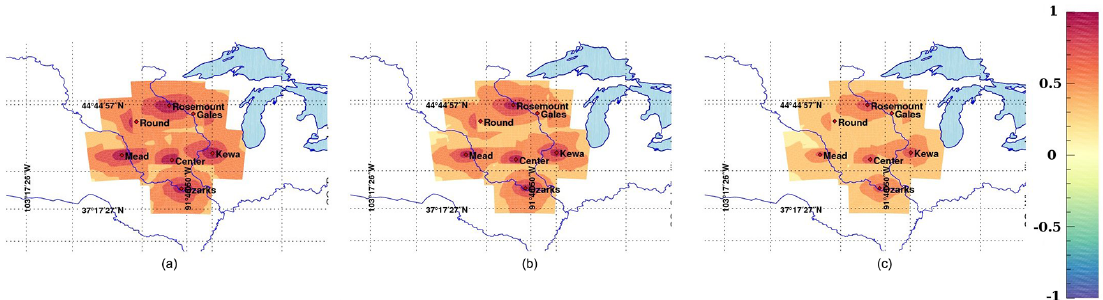
Figure 8. Raw (a) and filtered correlations of CO 2 in situ mole fractions at about 100ma.g.l. based on 25 members using the Schur localization (b) and Wiener and Schur filter (c)